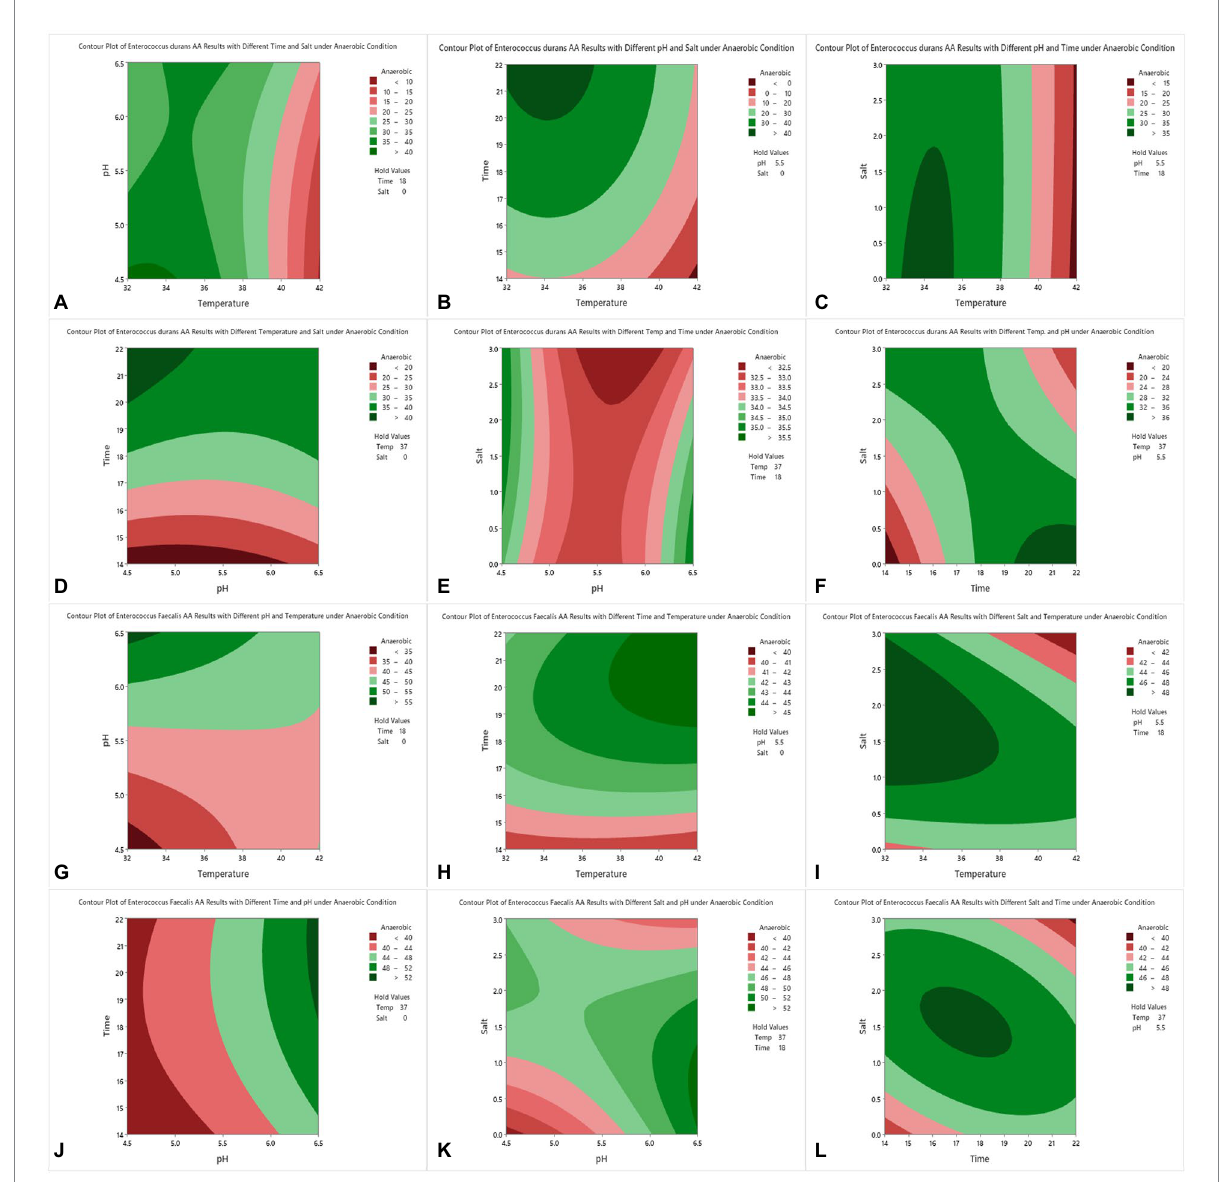
FIGURE 2 Contour plots of acrylamide removal in anaerobic conditions for E. durans (A–F) and E. faecalis (G–L) under controlled conditions of incubation time of 14–22 h, salt (NaCl) of 0.0–3.0%, incubation temperature of 32–42 ° C and pH of